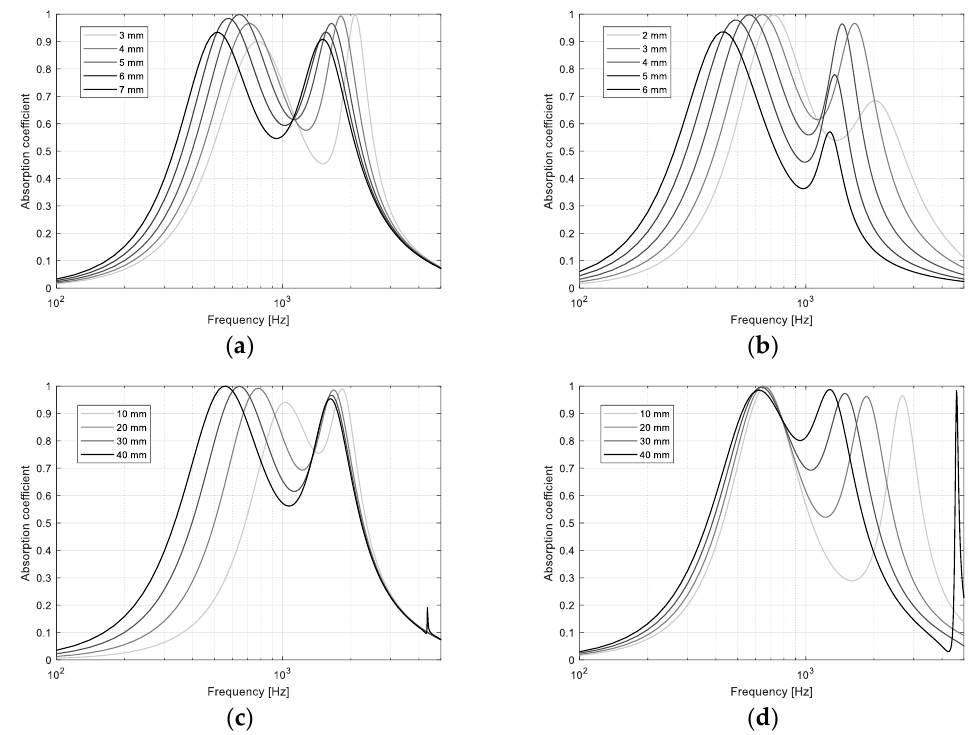
Figure 10. Comparison of the predicted sound absorption coefficients for double-membrane structure. ( a ) distance between holes of the innermost layer; ( b ) distance between holes of the outermost layer; ( c ) thickness of first air gap; and, ( d ) thickness of second air gap.